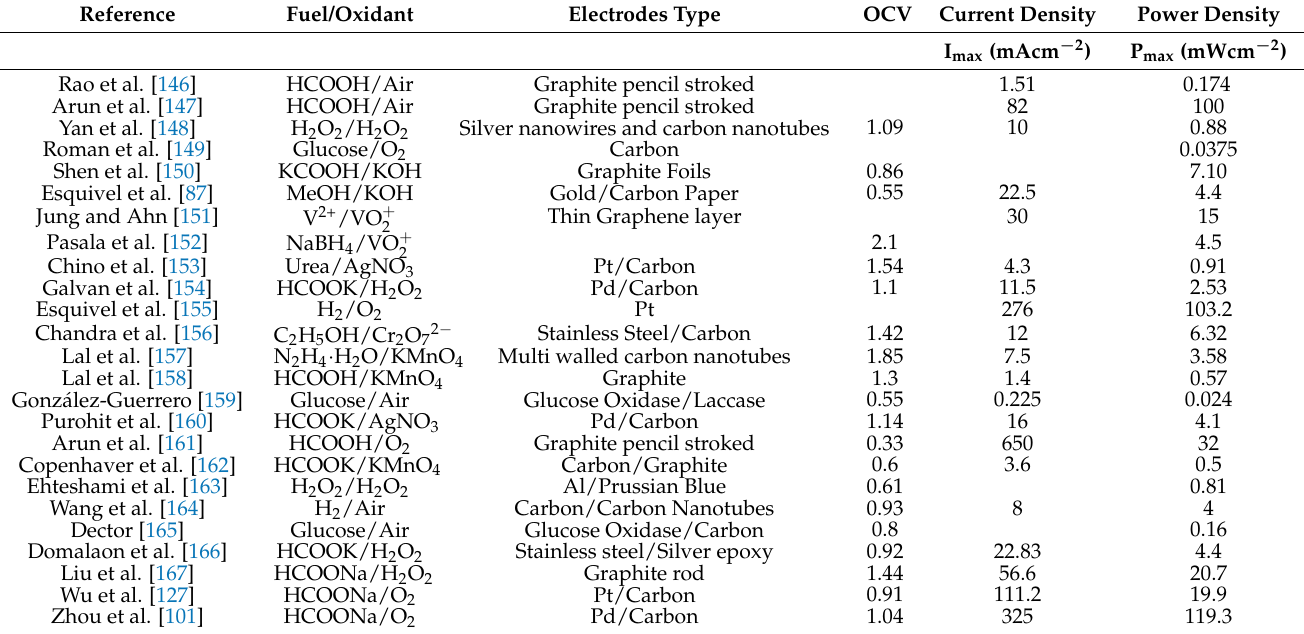
Table 1. Recent progresses made in lateral flow